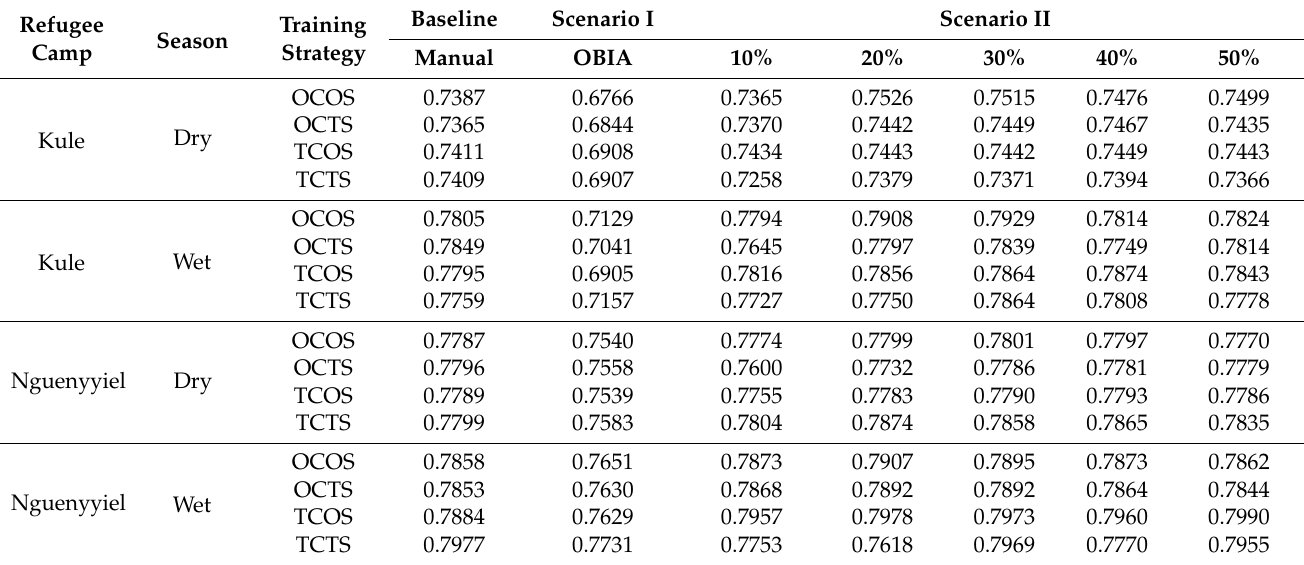
Table A1. The F1-score values of built-up structures of all implemented experiments.